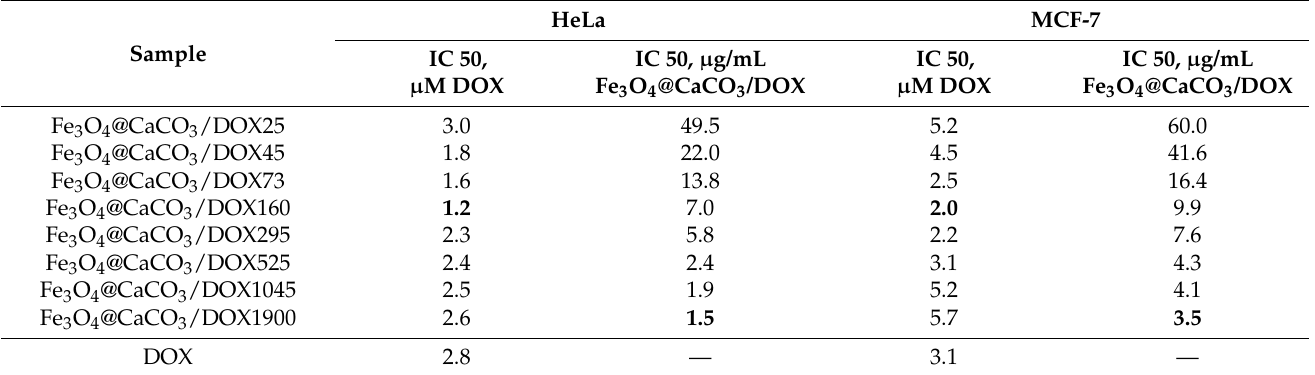
Figure 9. Cell viability assay using MTT. HeLa and MCF-7 cells were incubated with Fe 3 O 4 @CaCO 3 /DOX and free DOX for 48 h. Table 4. IC 50 of different types of Fe 3 O 4 @CaCO 3 /DOX and free DOX on HeLa and MCF-7